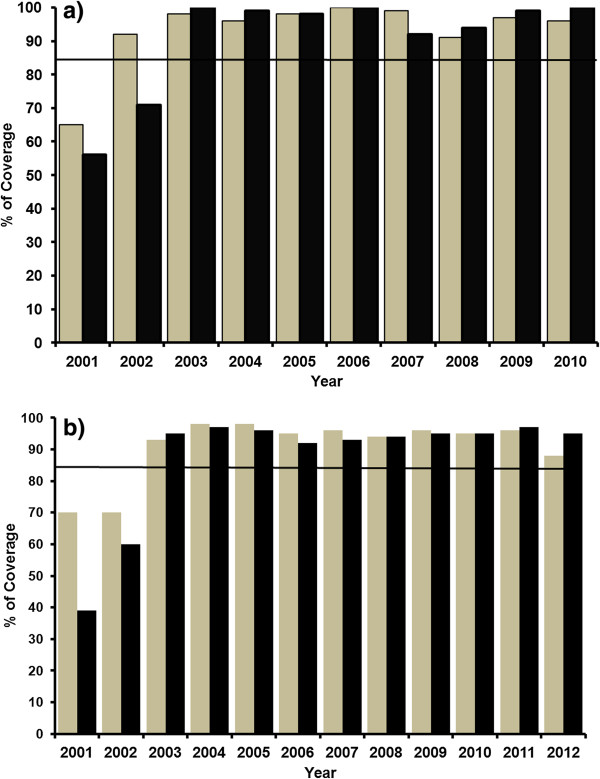
Coverage rate with ivermectin, northern Venezuela. Coverage rate (percent) with ivermectin of the eligible population of the North-central (a) and North-east (b) foci, Venezuela, 2001–2012. The line at 85% indicates the coverage needed in a sustained way to interrupt transmission.